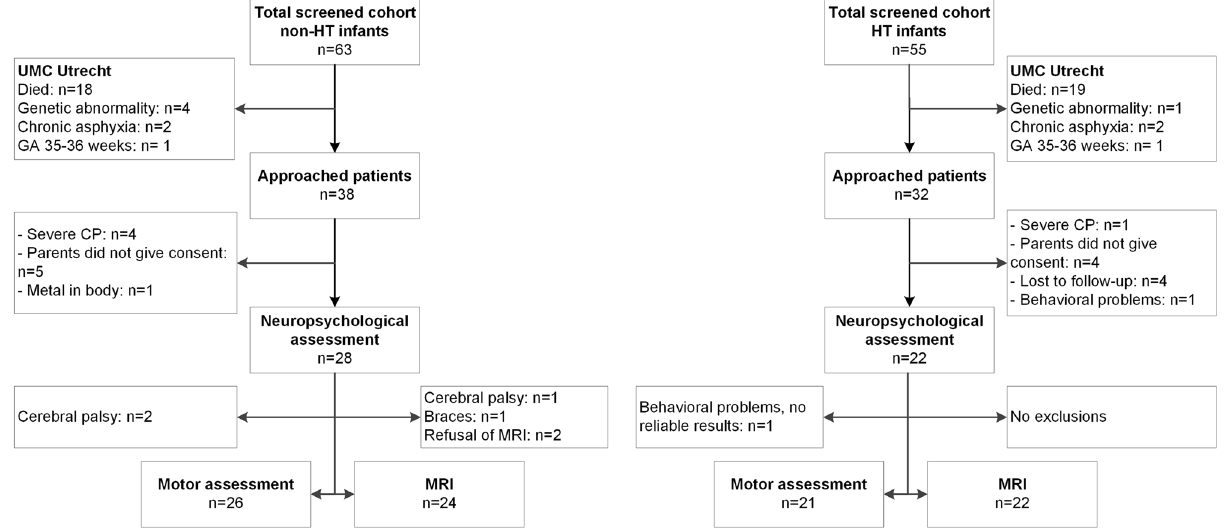
Figure 2. Flow chart of inclusion and exclusion for the children in the non-HT group (left) and for the children in the HT group (right). For Isala Clinics only data were available from the approached